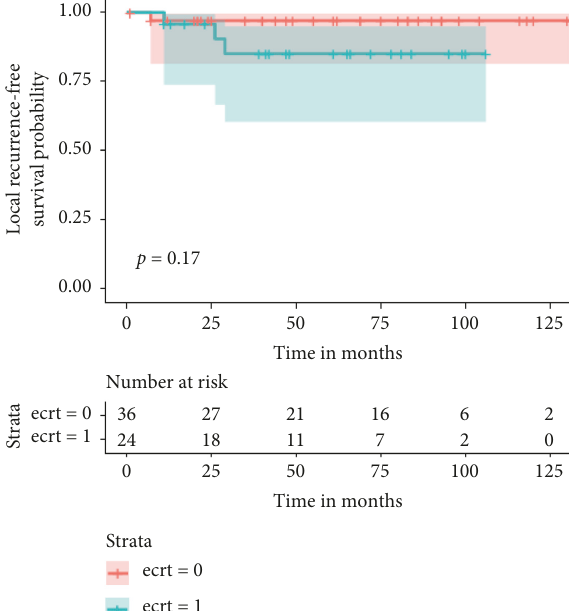
Figure 1: Kaplan-Meier curves showing local recurrence-free survival stratified by use of reimplantation. Green line with reimplantation of tumor bone and the red without. Time is in months.